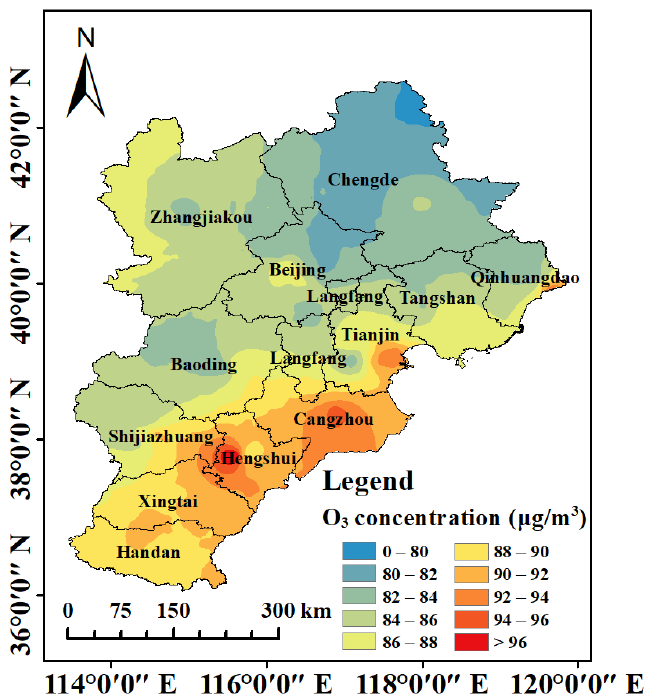
Figure 9. Spatial distribution of annual maximum 8-h average O 3 concentration.